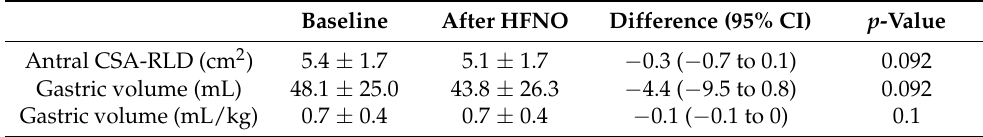
Table 2. Antral Cross-Sectional Area and Gastric Volume.